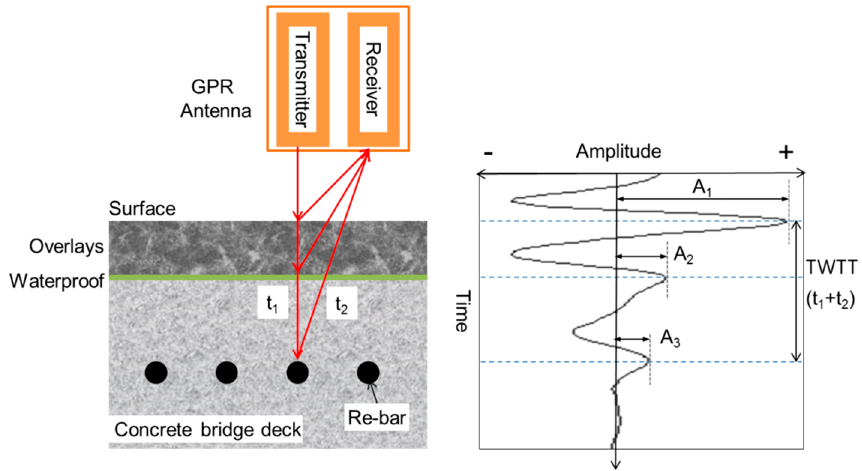
Figure 1. Illustration of Ground Penetrating Radar (GPR) scanning on an asphalt-covered concrete bridge deck and a possible path of electromagnetic (EM) waves.